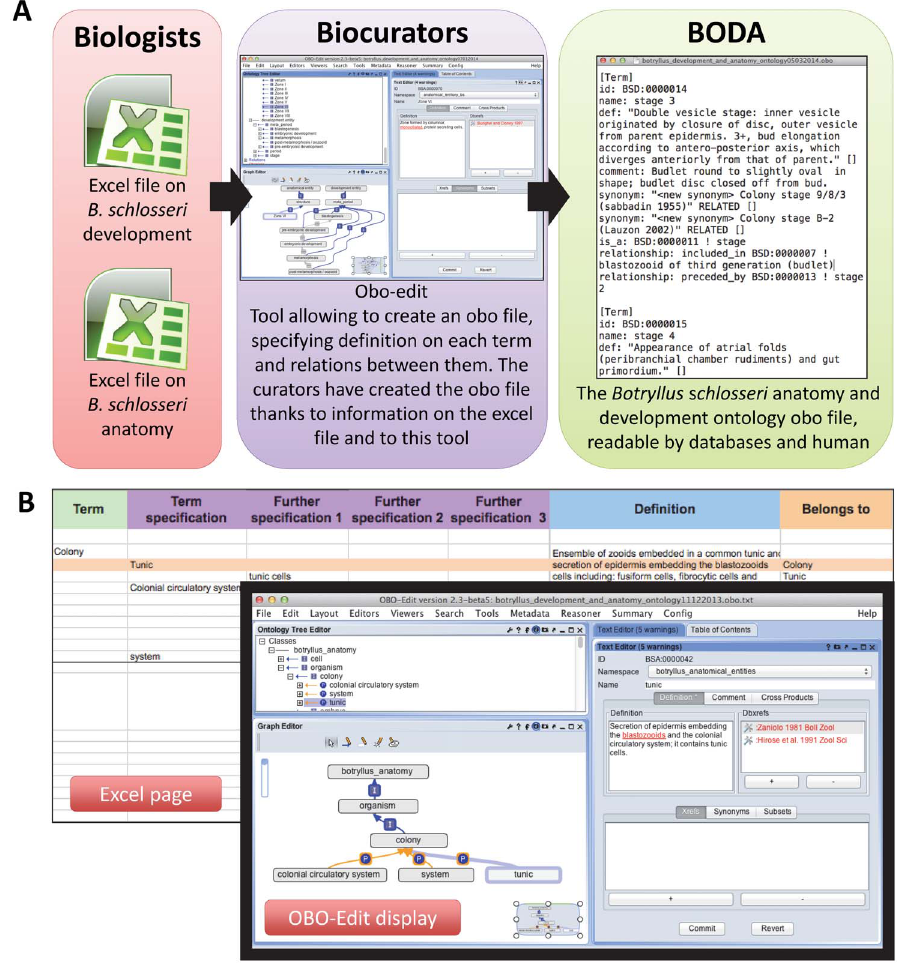
Figure 1. The workflow adopted to build BODA. A. Schemes illustrating the workflow adopted to build BODA requiring strict collaboration between experts in B. schlosseri biology and biocurators. B. An Excel page and its corresponding display on OBO-edit. In the latter, you can see different visualization of the relationship ‘‘tunic is part of colony’’ (left panel of the OBO-Edit display); the definition and references of the term ‘‘tunic’’ are in the right panel (where you can also find synonyms, comments, etc, where introduced).